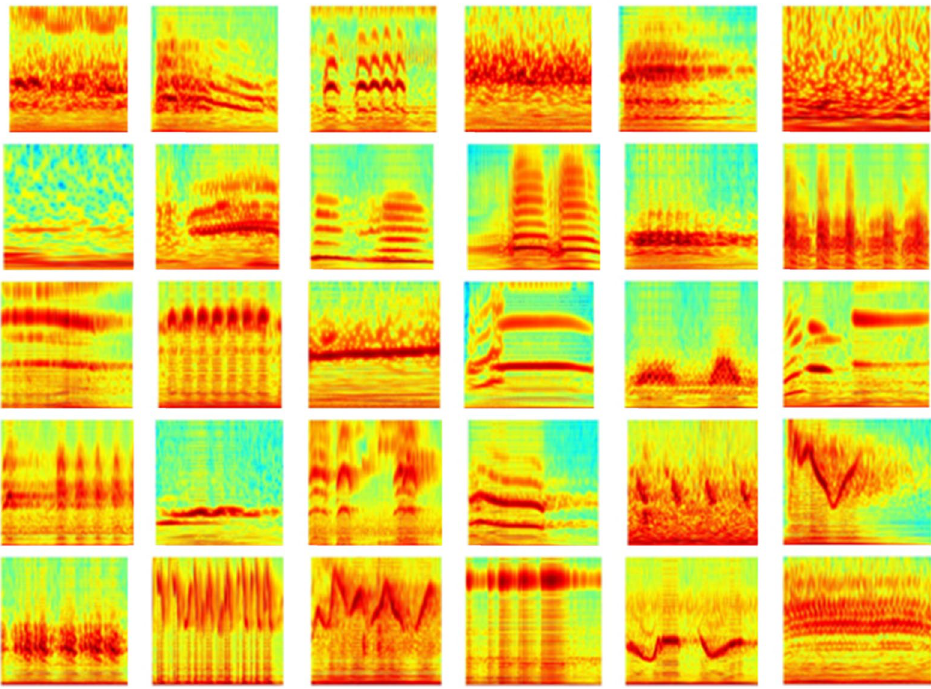
Figure 6. Wavelet spectrograms. The WT spectrogram is arranged from top to bottom and from left to right according to the bird number in Table1. The x-axis and y-axis of the wavelet spectrogram represents the time domain and frequency-scale domain respectively, and the color is energy information, the hotter color the more energy is.